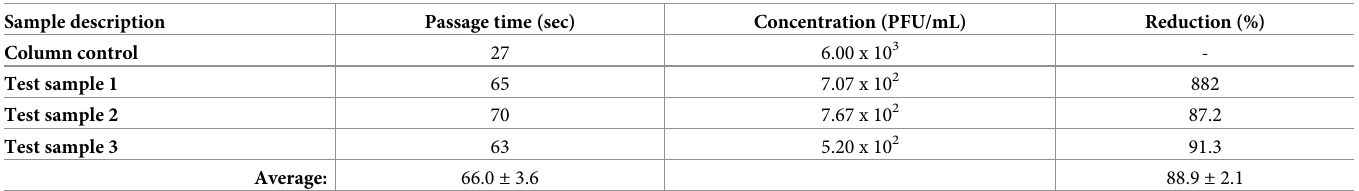
Table 9. NR-56461: Isolate hCoV-19/USA/MD-HP20874/2021 (Lineage B.1.1.529; Omicron Variant). Sample